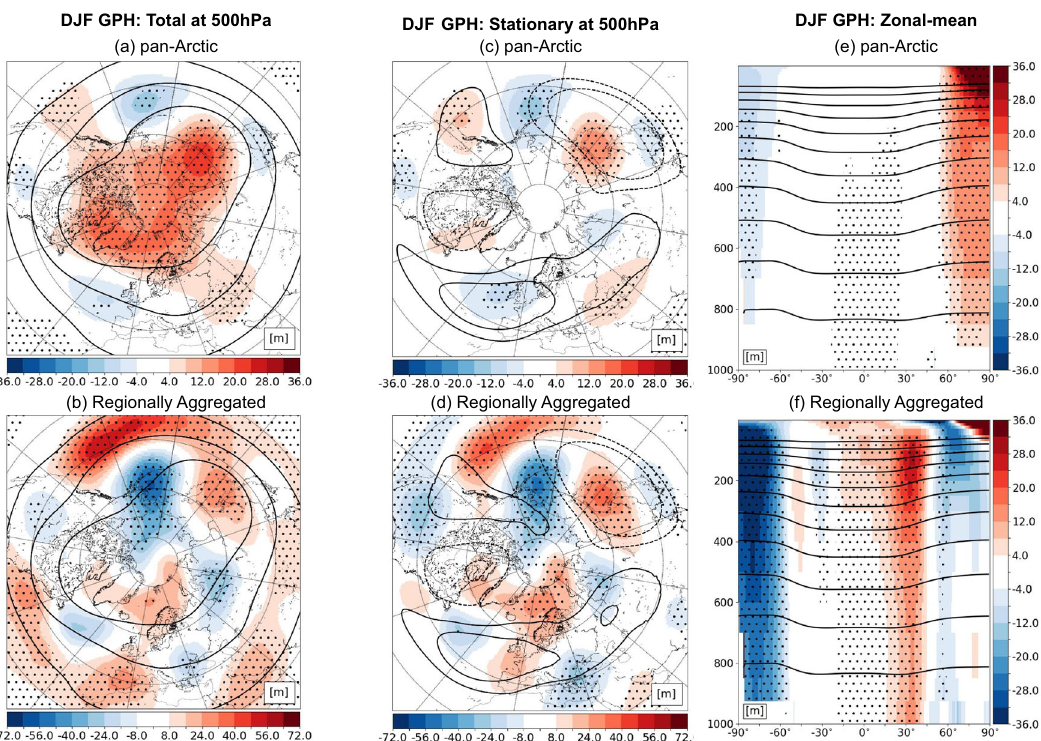
Fig. 2 Decomposing the stationary and zonal-mean atmospheric circulation responses in winter to future Arctic sea-ice loss. DJF anomalies in the future Arctic experiment (upper row) and the aggregated contributions from all future regional experiments (lower row) for: a , b the geopotential height (GPH) at 500 hPa, c , d the stationary (zonally asymmetric) component of the GPH at 500 hPa, e , f the zonal-mean component of the GPH. Anomalies (shown in colors) are computed as the difference between the future experiments and the present-day experiment climatologies. Black contours show the corresponding present-day climatologies (solid lines correspond to 5000, 5250, 5500, and 5750-m levels in ( a , b ); 50 and 100-m levels in ( c , d ) and 2000-m increments in ( e , f ); dashed lines represent − 100 and − 50-m levels in ( c , d )). The stationary component in ( c , d ) is de fi ned by subtracting the zonal-mean from the total anomalies. The zonal-mean panels ( e , f ) are pressure level [hPa] – latitude [deg] cross-sections. Dotted areas indicate regions where the sign of the anomalies agrees in at least 95% of the 1000 bootstrapped